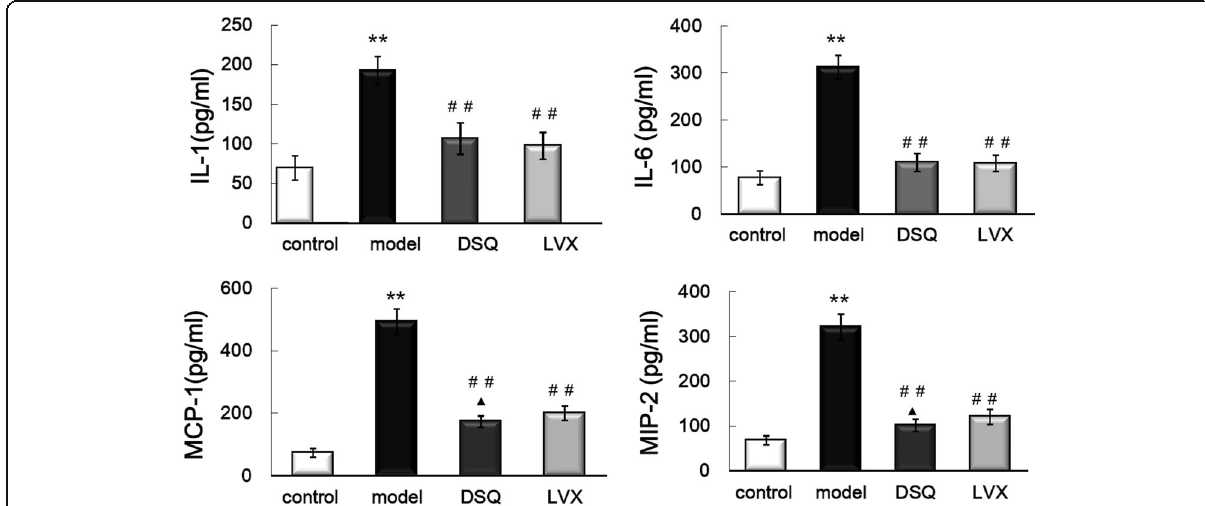
Fig. 2 Levels of IL-1 β , IL-6, MCP-1 and MIP-2 in the lungs in control, model, DSQ and LVX groups ** P <0.01 vs. control group; ## P <0.01 vs. model group; ▲ P <0.05 vs. LVX group. Values are expressed as mean ± S.D., one-way